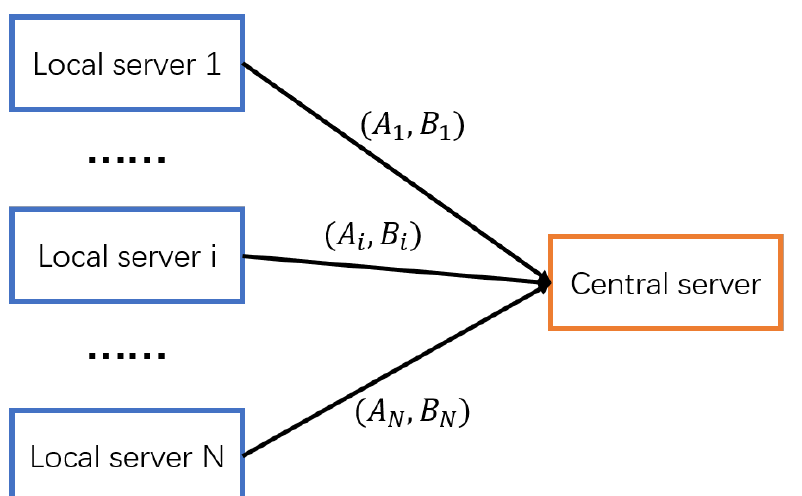
Figure 2. The classical one-shot communication process of distributed